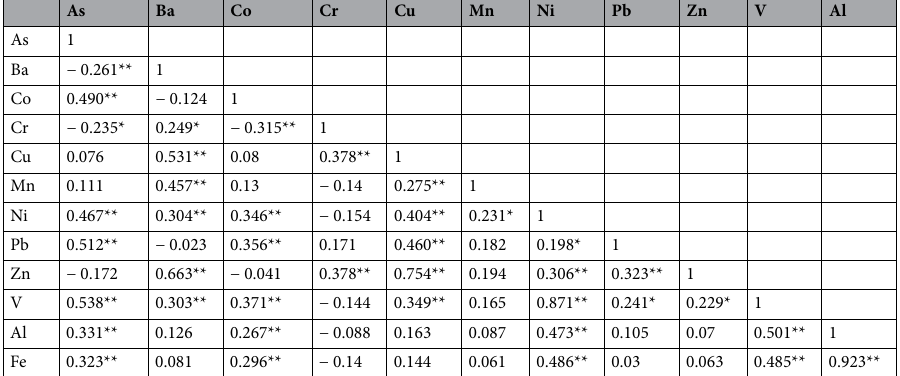
Table 3. Spearman correlation matrix of HMs in the urban topsoil of Mianyang. **Correlation is significant at P < 0.01 (2-tailed). *Correlation is significant at P < 0.05 (2-tailed).